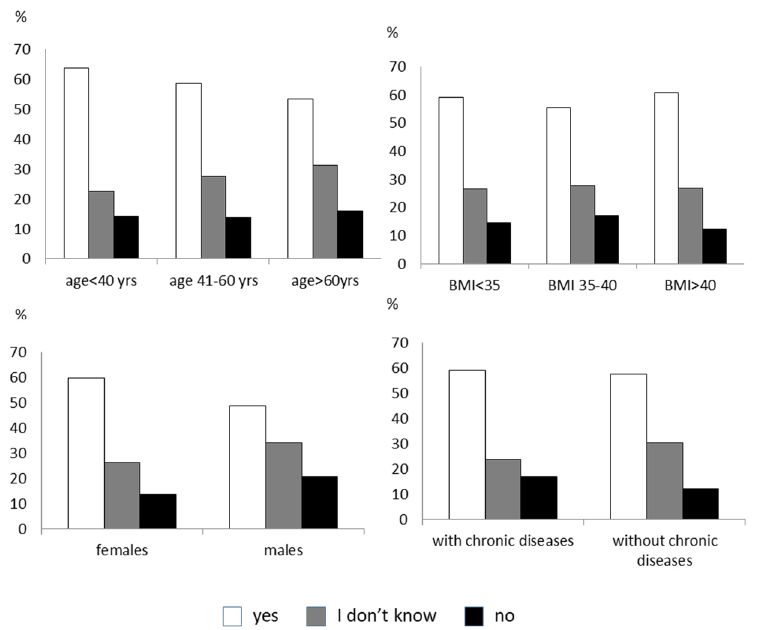
Figure 4. The figure shows the answer to the question: “Would you like to practice physical activity online supervised by an exercise physiologist?”. The responders are divided by age, sex, degree of obesity, and the presence of chronic diseases.